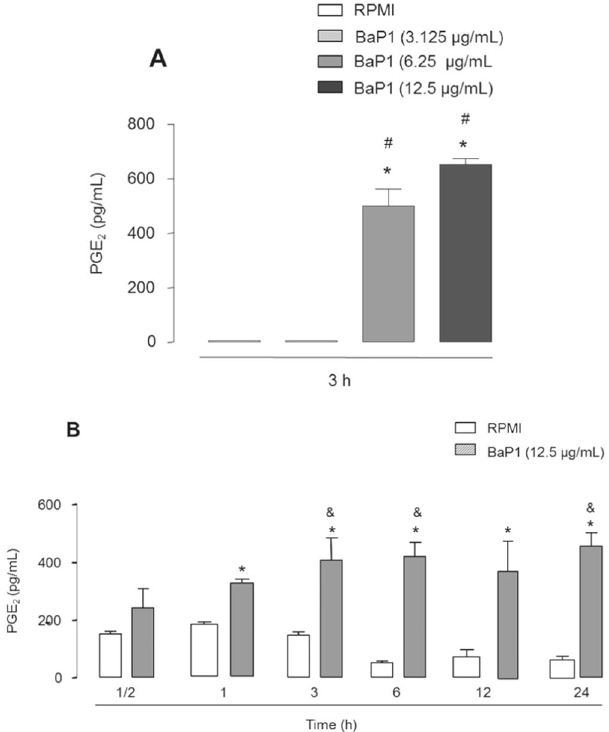
Figure 1. BaP1 induces production of PGE 2 in FLSs. ( A ) Effect of different concentrations of BaP1 on PGE 2 release in FLSs incubated with various concentrations of BaP1 or RPMI (control) for 3 h. ( B ) Time-course of BaP1-induced PGE 2 release. FLS monolayers were incubated with BaP1 (12.5 µ g/mL) or RPMI (control) for 30 min, 1, 3, 6, 12 and 24 h. Supernatants were collected, and PGE 2 was quantified by ELISA. Results are expressed as mean ± SEM of 4 samples. * p < 0.05 relative to control; # p < 0.05 relative to BaP1 (3.125 µ g/mL); & p < 0.05 relative to BaP1 (1 h) (one-way ANOVA, Bonferroni post test in A and two-way ANOVA, Bonferroni post test in